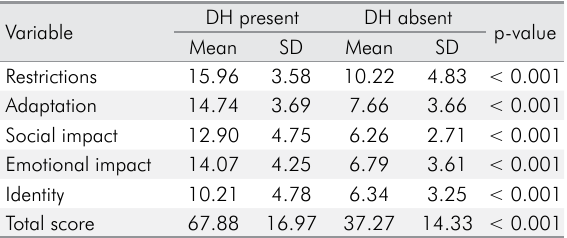
Table 5. Association between DHEQ-15 and dentin hypersensitivity (discriminant validity).